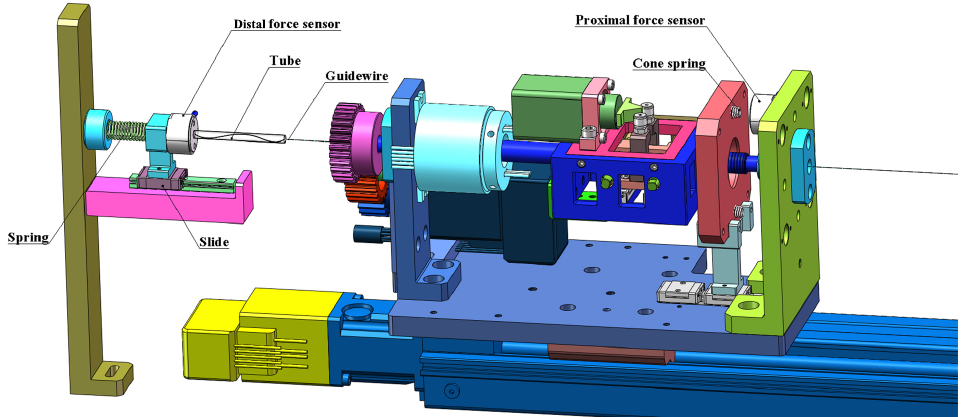
Figure 11. Experimental setup of force measurement. A tube is used to contain the guidewire, and the force applied on it is equal to the force on the entire tube, regardless of the bending state of